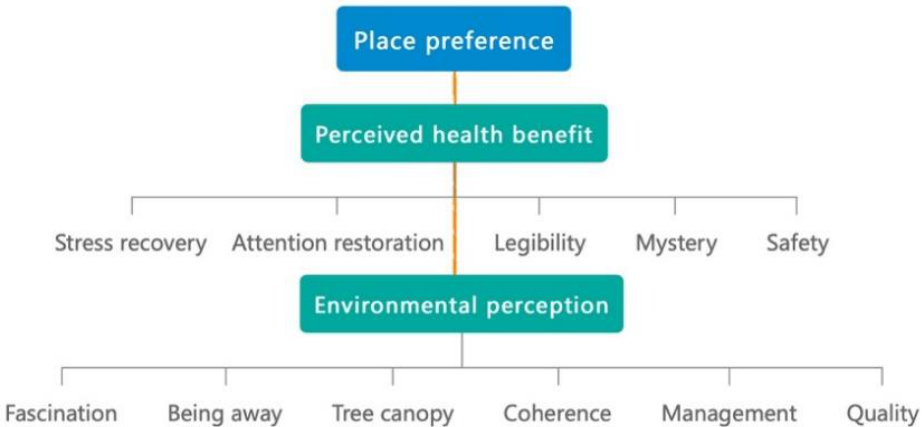
Figure 2. The classification of the influencing factors of greenway place preference.